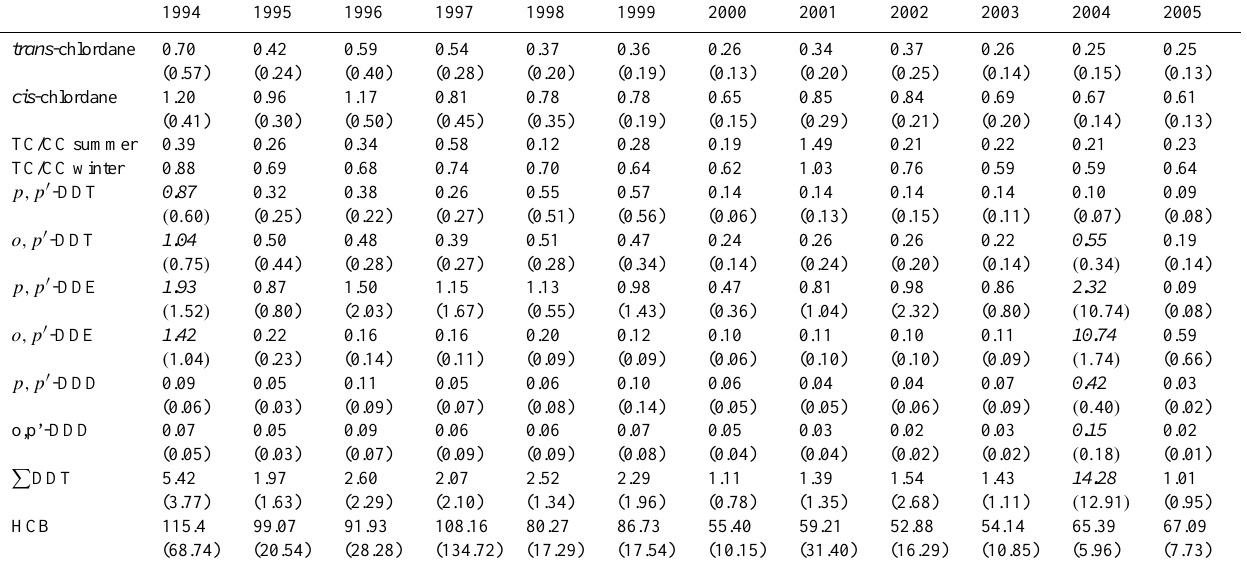
Table 1. Annual arithmetic means inpgm − 3 (standard deviation) for trans- chlordane (TC) and cis -chlordane (CC), DDT (individual com- pounds and total DDT) and HCB measured at Zeppelin, Svalbard, Norway 1994–2005. The average summer (June-August) and winter (January–March) ratios of TC/CC are also